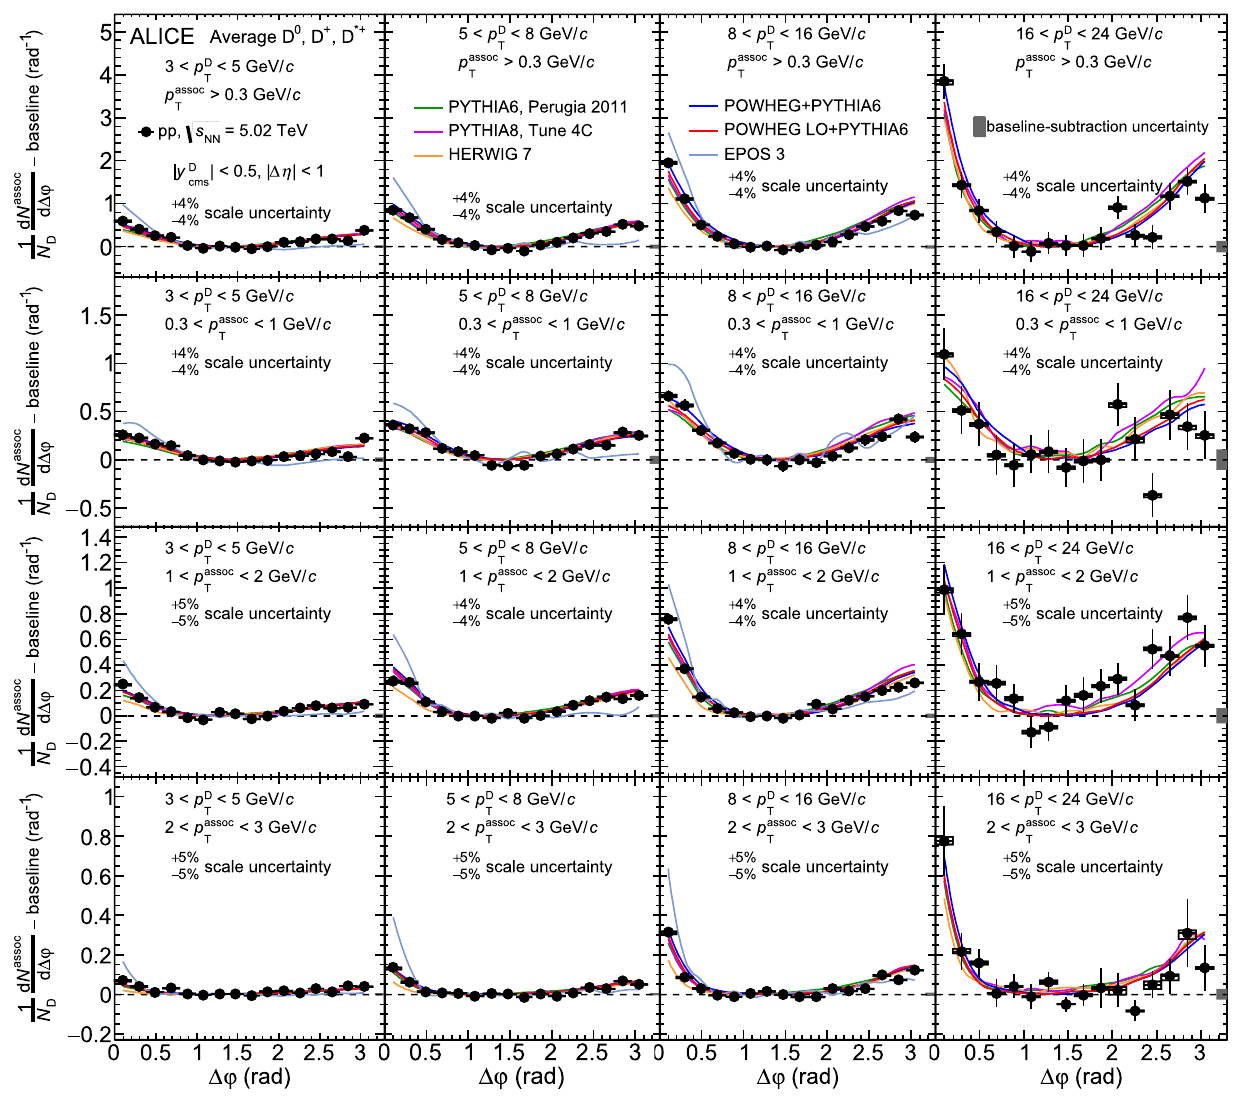
> 0 . 3 GeV / c , 0 . 3 < p assoc < 1 GeV / c , Fig. 8 The average of the azimuthal-correlation functions of D 0 , D + , (from left to right) and p assoc T T < 2 GeV / c , and 2 < p assoc < 3 GeV / c (from top to bot- and D ∗+ mesons with associated particles, after the subtraction of the 1 < p assoc √ T T s = 5 . 02 TeV, compared to predictions baseline, in pp collisions at tom). Statistical and (cid:4)ϕ -dependent systematic uncertainties are shown as vertical error bars and boxes, respectively, while the (cid:4)ϕ -independent from the PYTHIA, POWHEG+PYTHIA6, POWHEG LO+PYTHIA6, uncertainties are written as text. The uncertainties from the subtraction HERWIG, and EPOS 3 event generators with various configurations < 5 GeV / c , of the baseline are displayed as boxes at (cid:4)ϕ > (see text for details). The functions are shown for 3 < p D T < 8 GeV / c , 8 < p D < 16 GeV / c , and 16 < p D < 24 GeV / c 5 < p D T T T